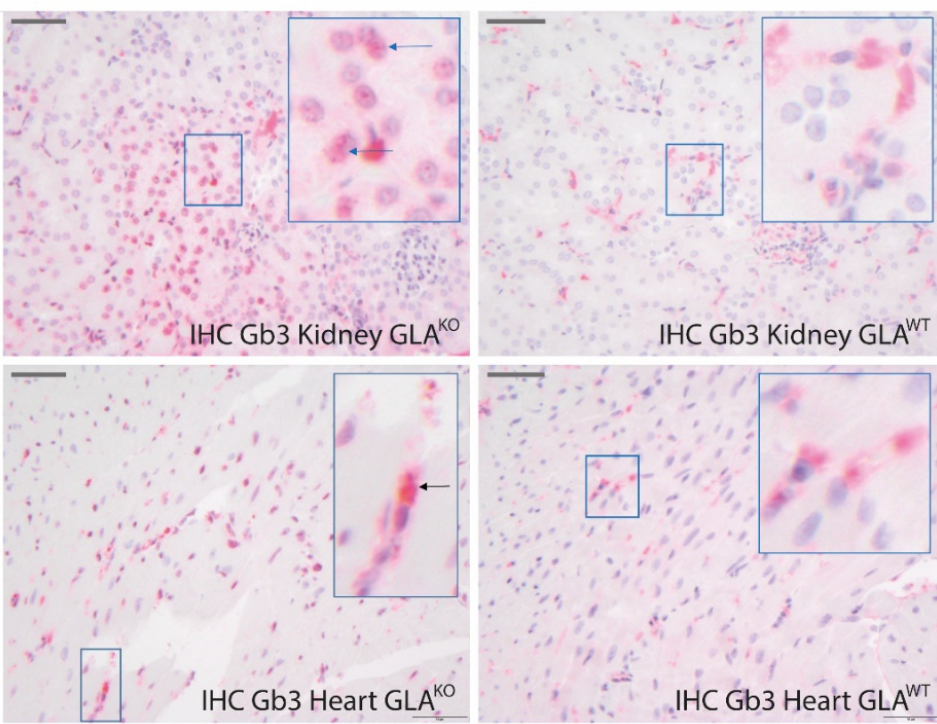
Figure 5. Immunohistochemical (IHC) staining of heart and kidney sections for Gb3 as a biomarker in FD. The organs were extracted from 20-week-old GLA KO and healthy wild-type (GLA WT ) mice. Scale bars represent 50 µ m. Images were captured using Olympus microscope BX51 with 40 × objective. Arrows show granular Gb3 positive stainings.